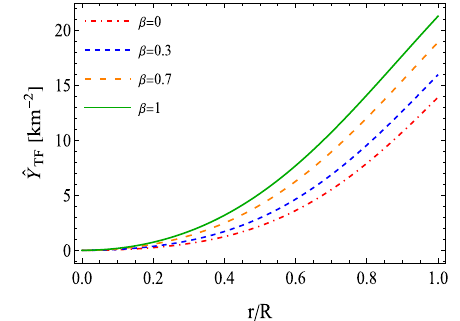
Fig. 7 The behavior complexity factor ˆ Y TF versus radial coordi- nate r / R for different decoupling constant β with compactness factor M s = 0 . 25 and F = 0 . 0005. The above complexity figure is plotted R for solution 4.2 corresponding to the case ˆ Y TF = Y